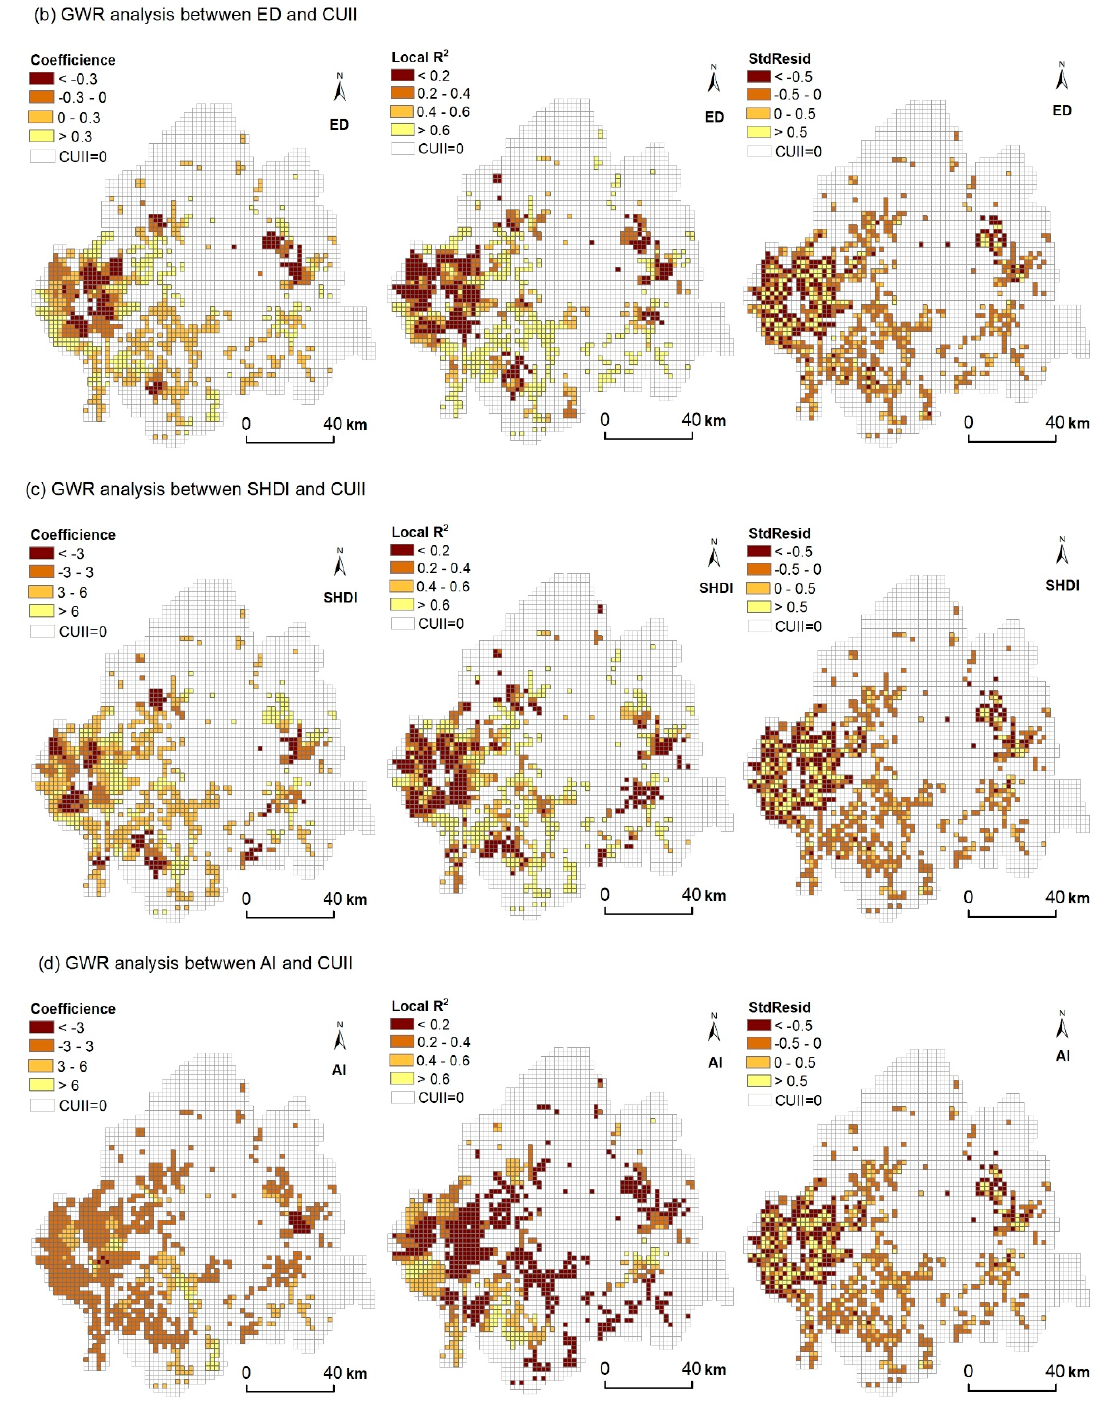
Figure 7. Local varying estimates of relationships between changes of ( a ) LPI and CUII, ( b ) ED and CUII, ( c ) SHDI and CUII, and ( d ) AI and CUII. CUII, ( c ) SHDI and CUII, and ( d ) AI and